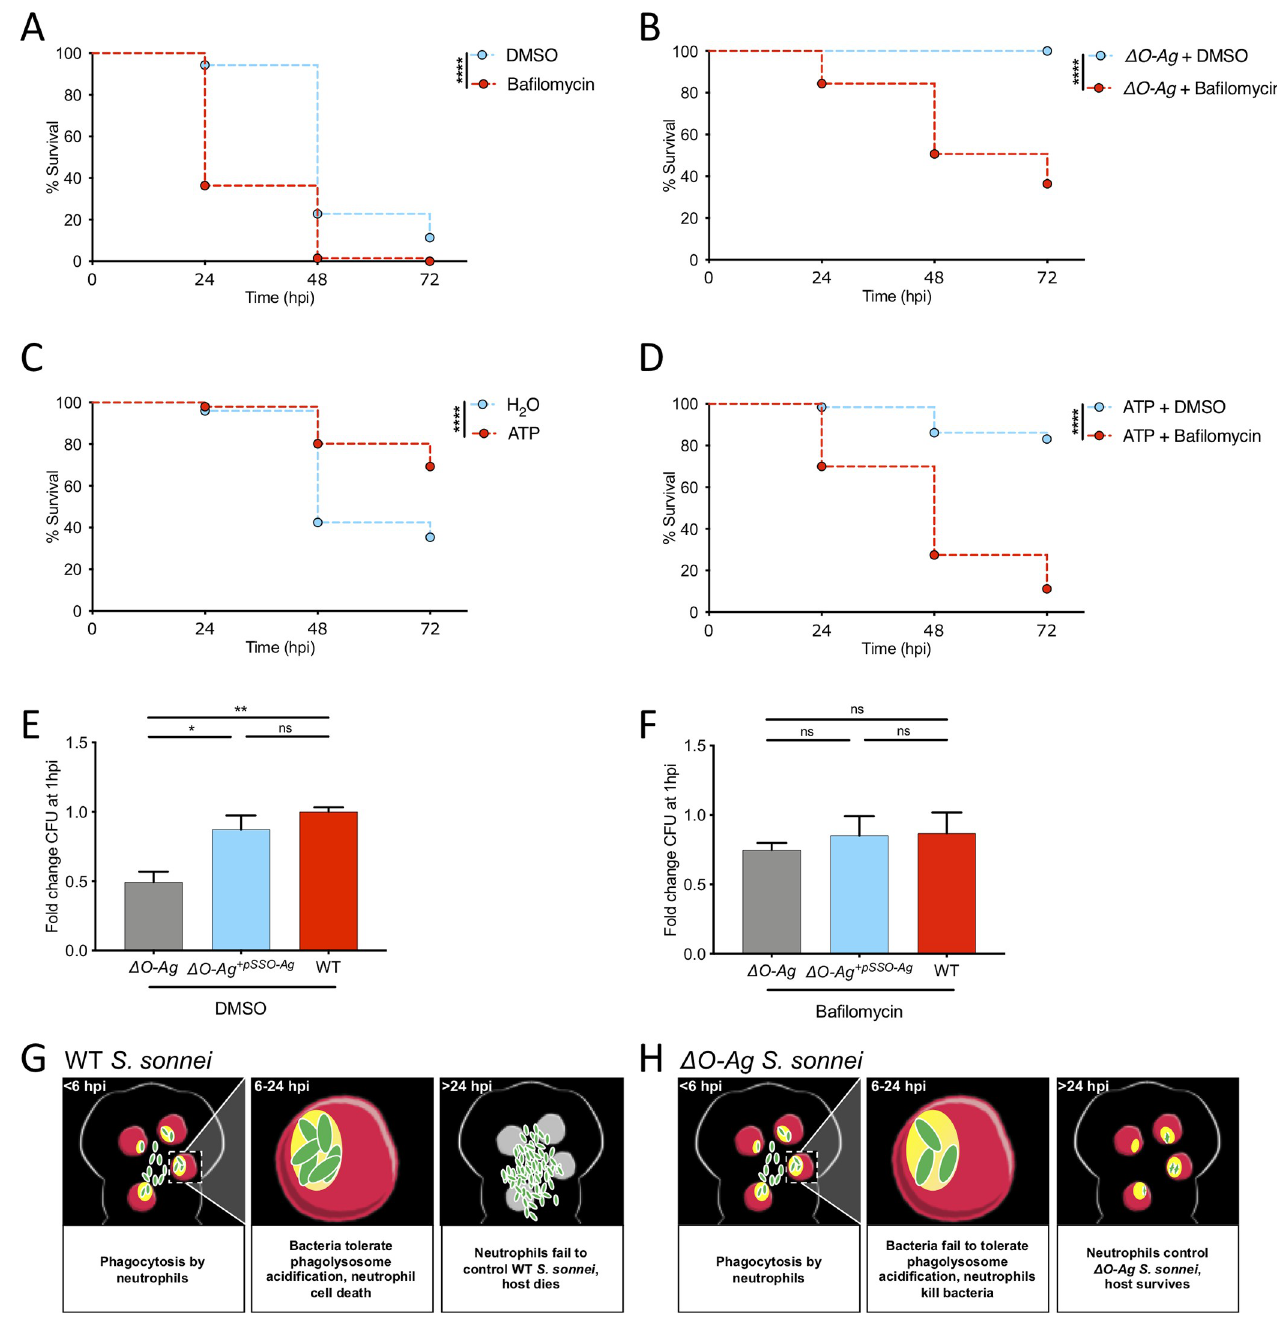
Fig 6. Phagolysosome acidification controls S . sonnei clearance by zebrafish and human neutrophils. A,B. Bafilomycin treatment increases susceptibility to WT and Δ O-Ag S . sonnei . Survival curves of larvae treated with control DMSO vehicle (blue) or Bafilomycin (red) upon infection in the HBV with WT (A) or Δ O-Ag (B) S . sonnei . Experiments are cumulative of 3 biological replicates. Bacterial input: ~7000 CFU. Statistics: Log-rank (Mantel-Cox) test; ���� p < 0.0001. C. ATP injections protect against S . sonnei infection. Survival curves of larvae injected in the HBV with control water (blue) or ATP (red) 3 hours prior to infection of the same compartment with S . sonnei . Experiments are cumulative of 3 biological replicates. Bacterial input: ~7000 CFU. Statistics: Log-rank (Mantel-Cox) test; ���� p < 0.0001. D. Bafilomycin treatment and ATP injections counteract each other. Survival curves of larvae injected in the HBV with ATP 3 hours prior to infection of the same compartment with S . sonnei and treatment with control DMSO vehicle (blue) or Bafilomycin (red). Experiments are cumulative of 3 biological replicates. Bacterial input: ~7000 CFU. Statistics: Log-rank (Mantel-Cox) test; ���� p < 0.0001. E,F. S . sonnei O-Ag is required to counteract acidification-mediated clearance by human neutrophils. Δ O-Ag (grey), complemented strain ( Δ O-Ag +pSSO-Ag , blue ) or WT (red) S . sonnei were incubated with peripheral human neutrophils and exposed to DMSO (vehicle control treatment, E) or Bafilomycin (F). Difference in bacterial killing was quantified by plating from lysates of infected neutrophils at 1 hpi. Experiments are cumulative of 3 biological replicates from 3 independent donors. Statistics: